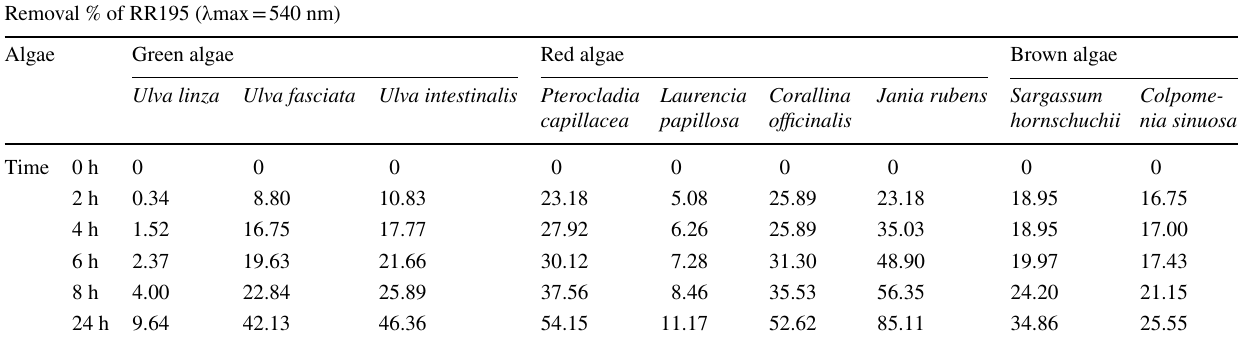
Table 4 Removal percentage of Reactive Red 195 (RR195) by the nine studied fresh algal species Removal % of RR195 (λmax = 540 nm) Algae Green algae